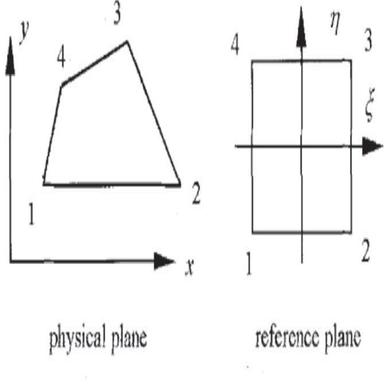
The quadrilateral element.